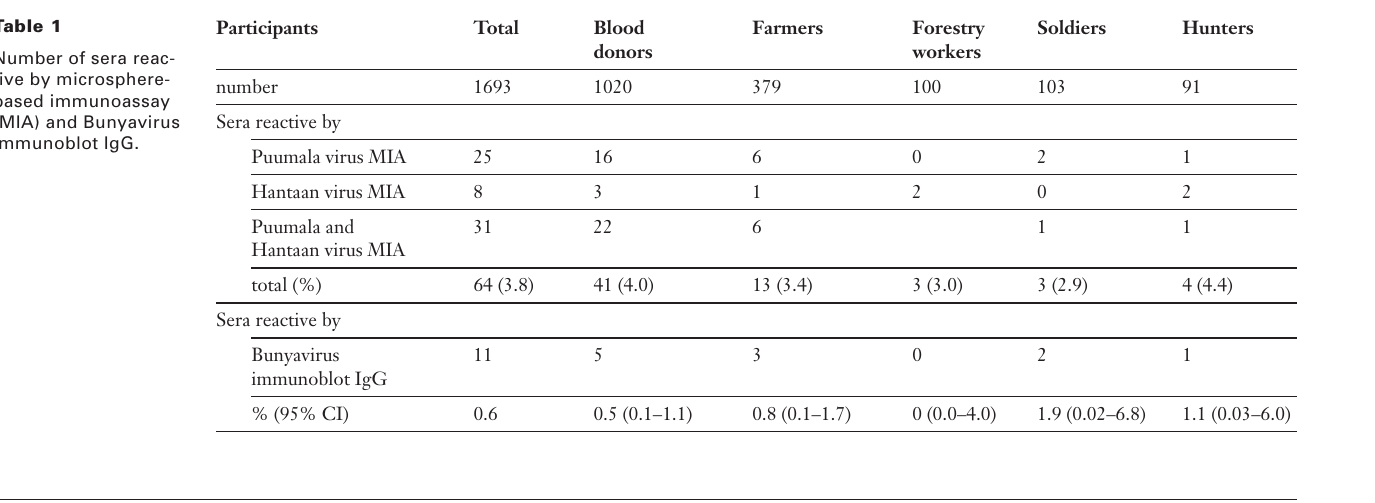
Participants and reactivity of